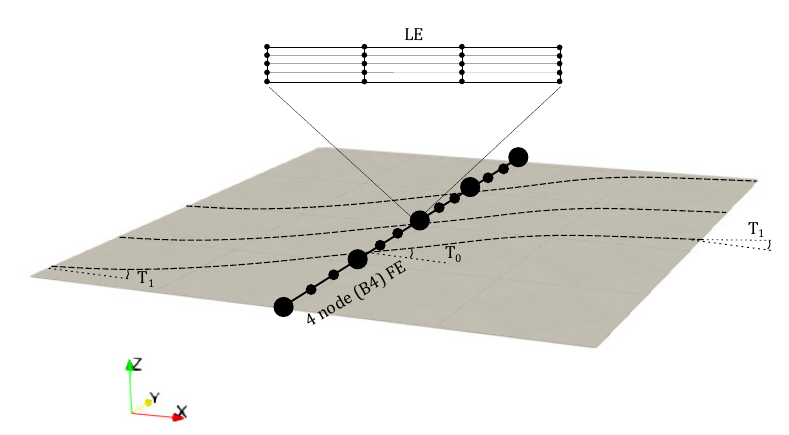
Figure 1. Representation of the finite element (FE) and Lagrange expansion (LE) theories employed over the macroscale structure. FE are used along the longitudinal axis and LE are utilised for the cross-section. T 0 and T 1 represent the fibre orientation at the centre of the plate and at the edge,